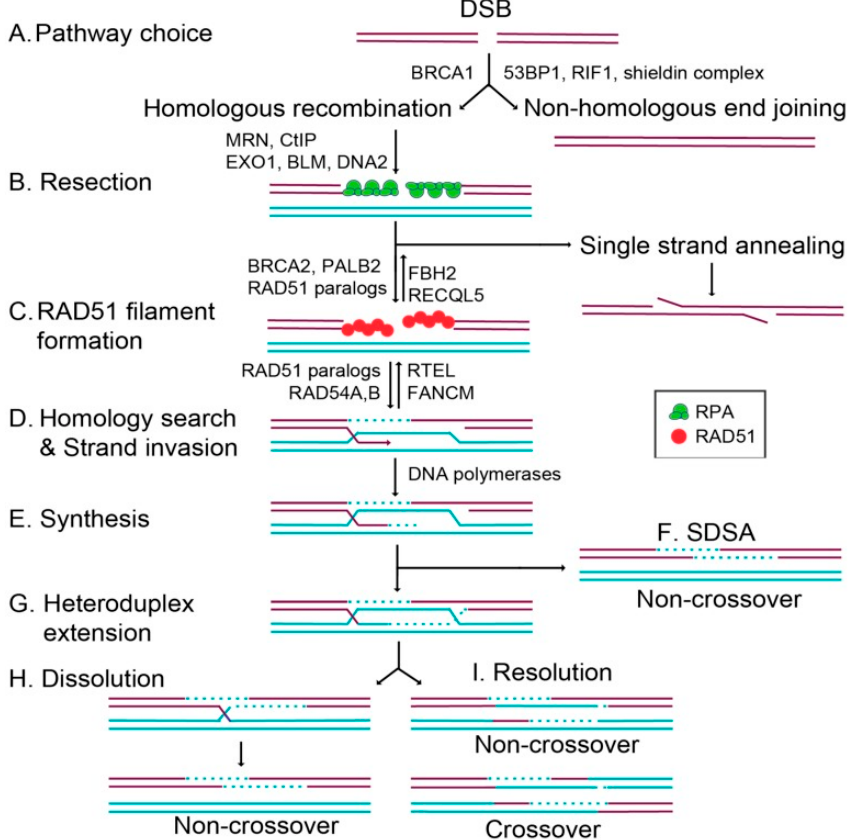
Figure 1. Schematic representation of double-strand break repair by homologous recombination (HR). The scheme explains the mechanism through which cells repair the damage resulting from the formation of a DSB that is displayed in purple lines. As shown in the first step, cells either repair the damage through HR or NHEJ pathways. (A) This choice of any of the two pathways is usually mediated by different factors; the BRCA1 promotes the HR pathway whereas 53BP1, RIF1, and the shieldin complex promote NHEJ. (B) In the second step, a resection by the MRN (MRE11–RAD51–NBS1) complex, CtIP, EXO1, BLM, as well as DNA2 creates 3 ′ ssDNA overhangs, coated by the trimeric replication protein A (RPA) which is displayed as a complex of green circles. During canonical homologous recombination, RPA undergoes displacement by RAD51 which is displayed as a complex of red circles. An alternative approach is also displayed where RAD51-independent repair may occur through single-strand annealing, which ends up with both the DNA ends ligated together. (C) In the third step, regulation of the RAD51 filament formation by BRCA2, PALB2, and the RAD51 paralogs takes place. Simultaneously, RAD51 is negatively regulated by FBH2 and RECQL5. (D) In the fourth step, RAD51-mediated homology search and strand invasion occurs, which is regulated by the RAD51 paralogs and RAD54A,B. At the same time, RAD51-mediated D loops are